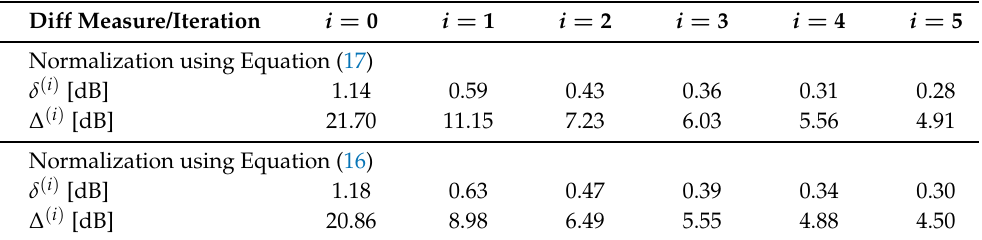
Table 1. Inconsistency measures δ ( i ) and ∆ ( i ) between the normalized mel spectrogram and mel spectrogram calculated from the audio signal normalized